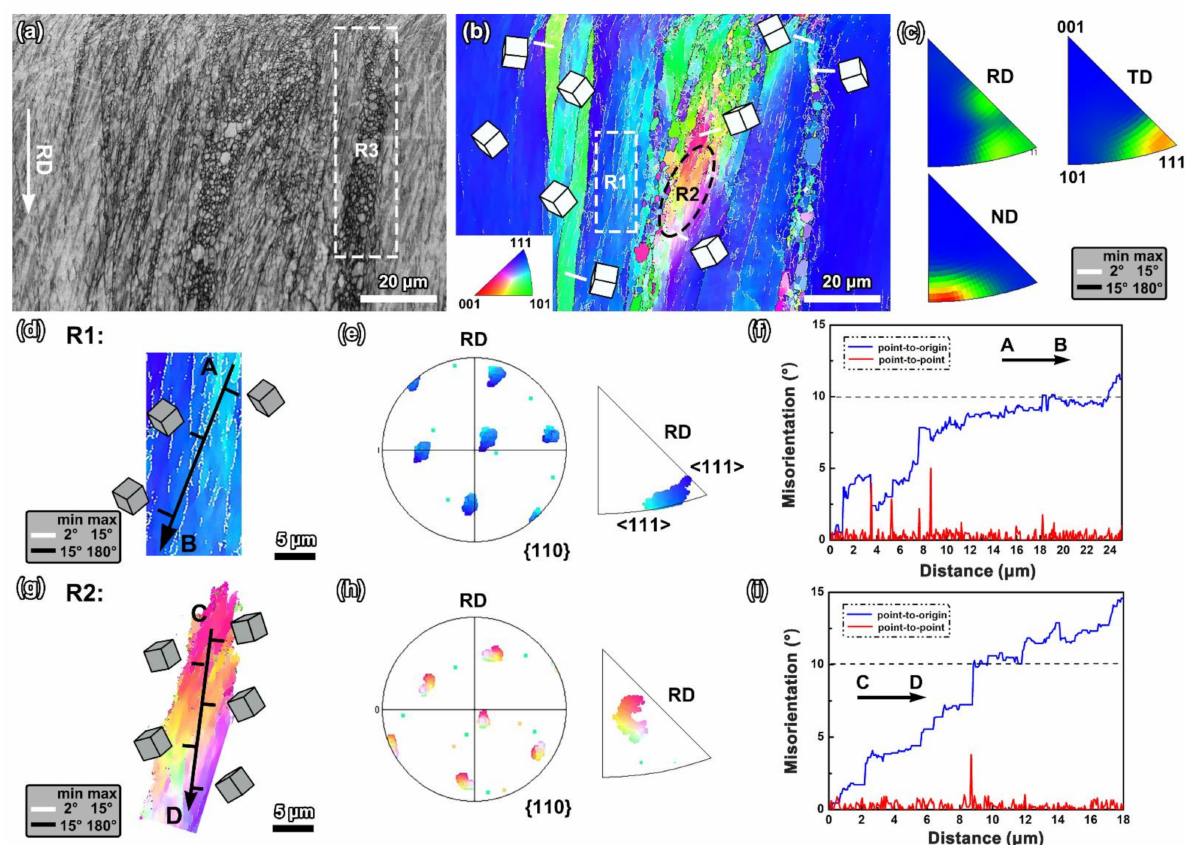
Figure 3. EBSD analysis of the specimen HT-1: ( a ) band contrast map (BC); ( b ) inverse pole figure (IPF); ( c ) pole figure (PF); ( d , g ) IPF map of R1 and R2 regions; ( e,h ) the corresponding (110) PF; ( f , i ) the misorientation angle along the black arrow AB and CD. Here, TD is the Transverse direction of sheet, ND is the Normal direction of the sheet, RD is the Rolling direction of the sheet, R3 is shown in Figure